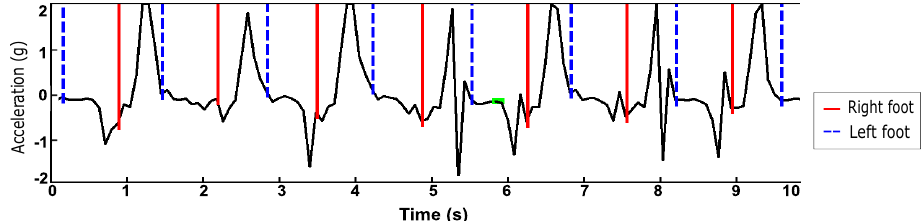
Figure 4. Samples taken from the ankle accelerometer signal associated with four different types of shift. The first two rows provide examples of first and last steps being taken. The third row demonstrates a pivot. The fourth row demonstrates a